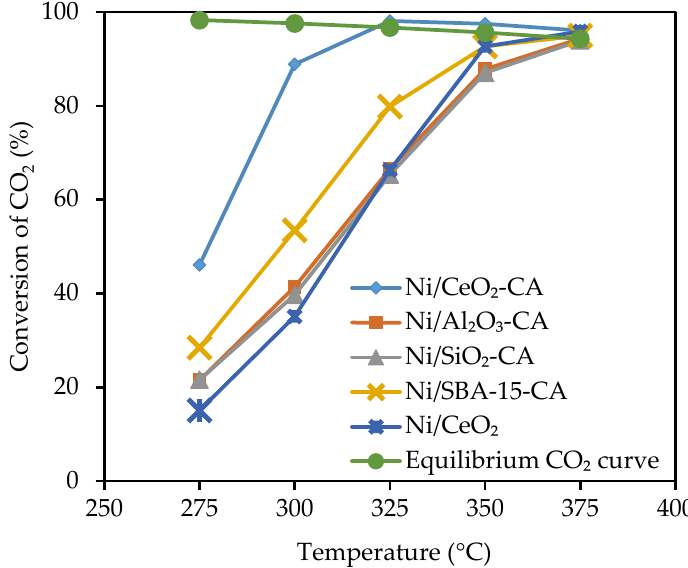
Figure 6. E ff ect of temperature on CO 2 conversion over di ff erent catalysts: H 2 :CO 2 :CH 4 = 4:1:1, Figure 6. Effect of temperature on CO 2 conversion over different catalysts: H 2 :CO 2 :CH 4 = 4:1:1, WHSV WHSV = 45 L / h g catalyst and pressure = 12.5 = 45 L/h g catalyst and pressure = 12.5 bar.